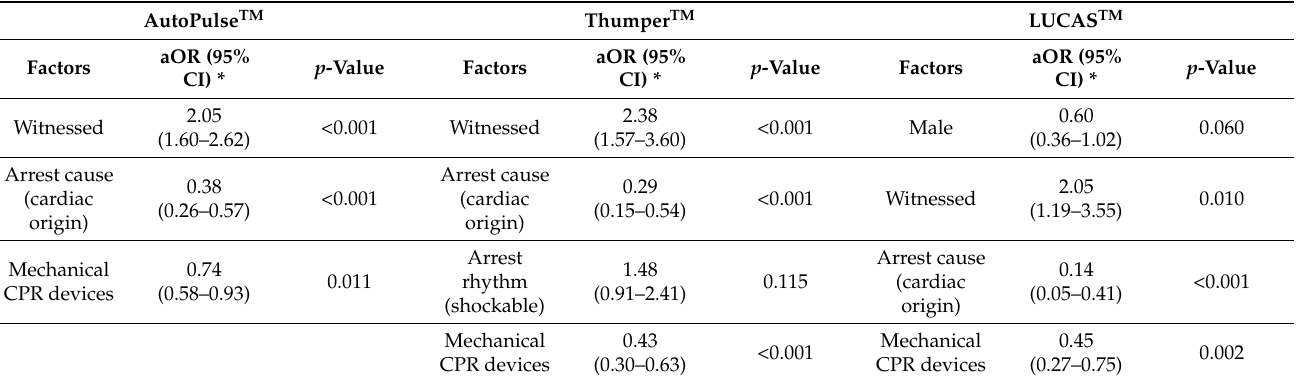
Table 3. Matched multivariate analysis for three types of mechanical CPR devices with respect to sustained ROSC.